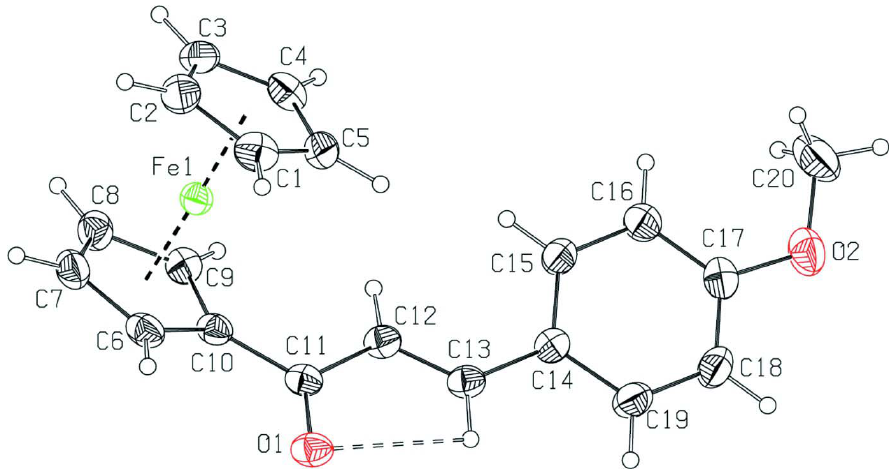
Figure 1 The molecular structure of the title compound, showing 30% probability displacement ellipsoids. The C–H···O intra- molecular hydrogen bond is shown as dashed lines.